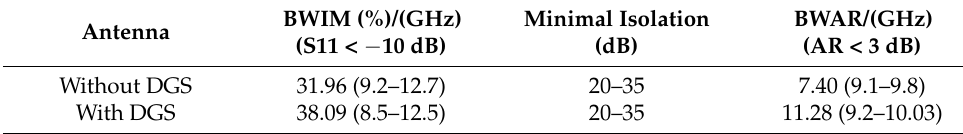
Figure 7. ( a ) S-parameters and ( b ) AR response of two-port antenna with and without slots in the ground plane.